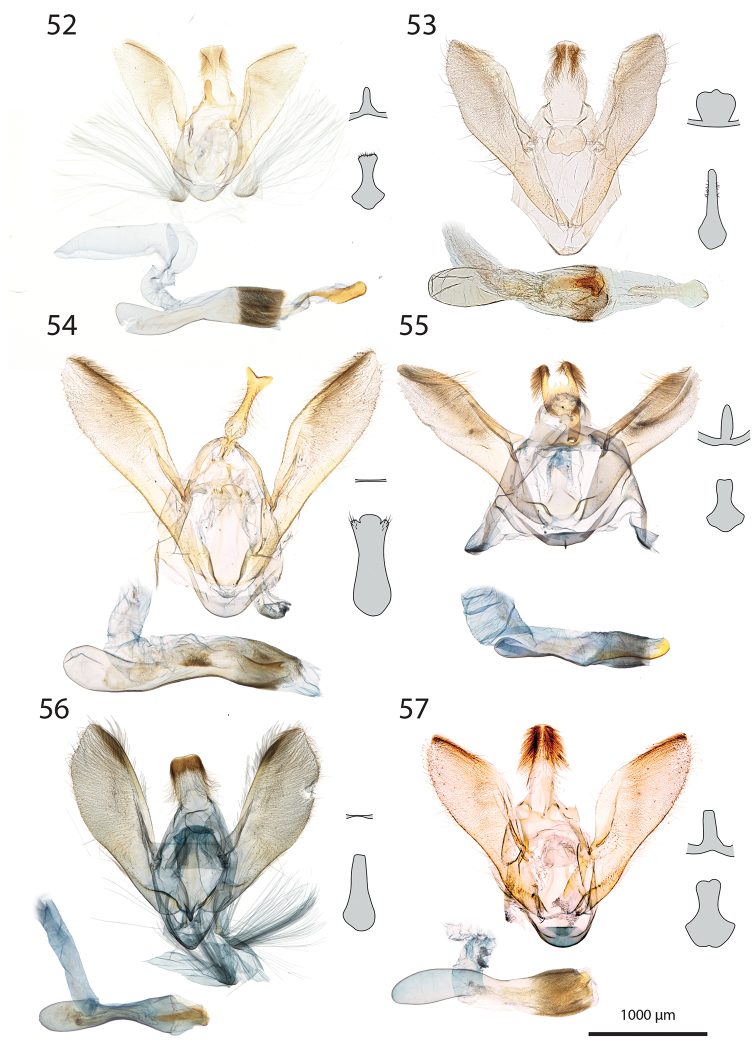
Male genitalia features of Hoploscopa. 52Hoploscopa
luteomacula Nuss, holotype, GU prep. Nuss 744 ♂ 53Hoploscopa
obliqua, holotype, Pyralidae Brit. Mus. Slide N° BMNH20252 ♂ (phallus with juxta attached) 54Hoploscopa
gombongi sp. nov., holotype, TL653 ♂ 55Hoploscopa
tonsepi sp. nov., paratype, TL661 ♂ 56Hoploscopa
niveofascia sp. nov., holotype, TL442 ♂ 57Hoploscopa
marijoweissae sp. nov., holotype, TL710 ♂.